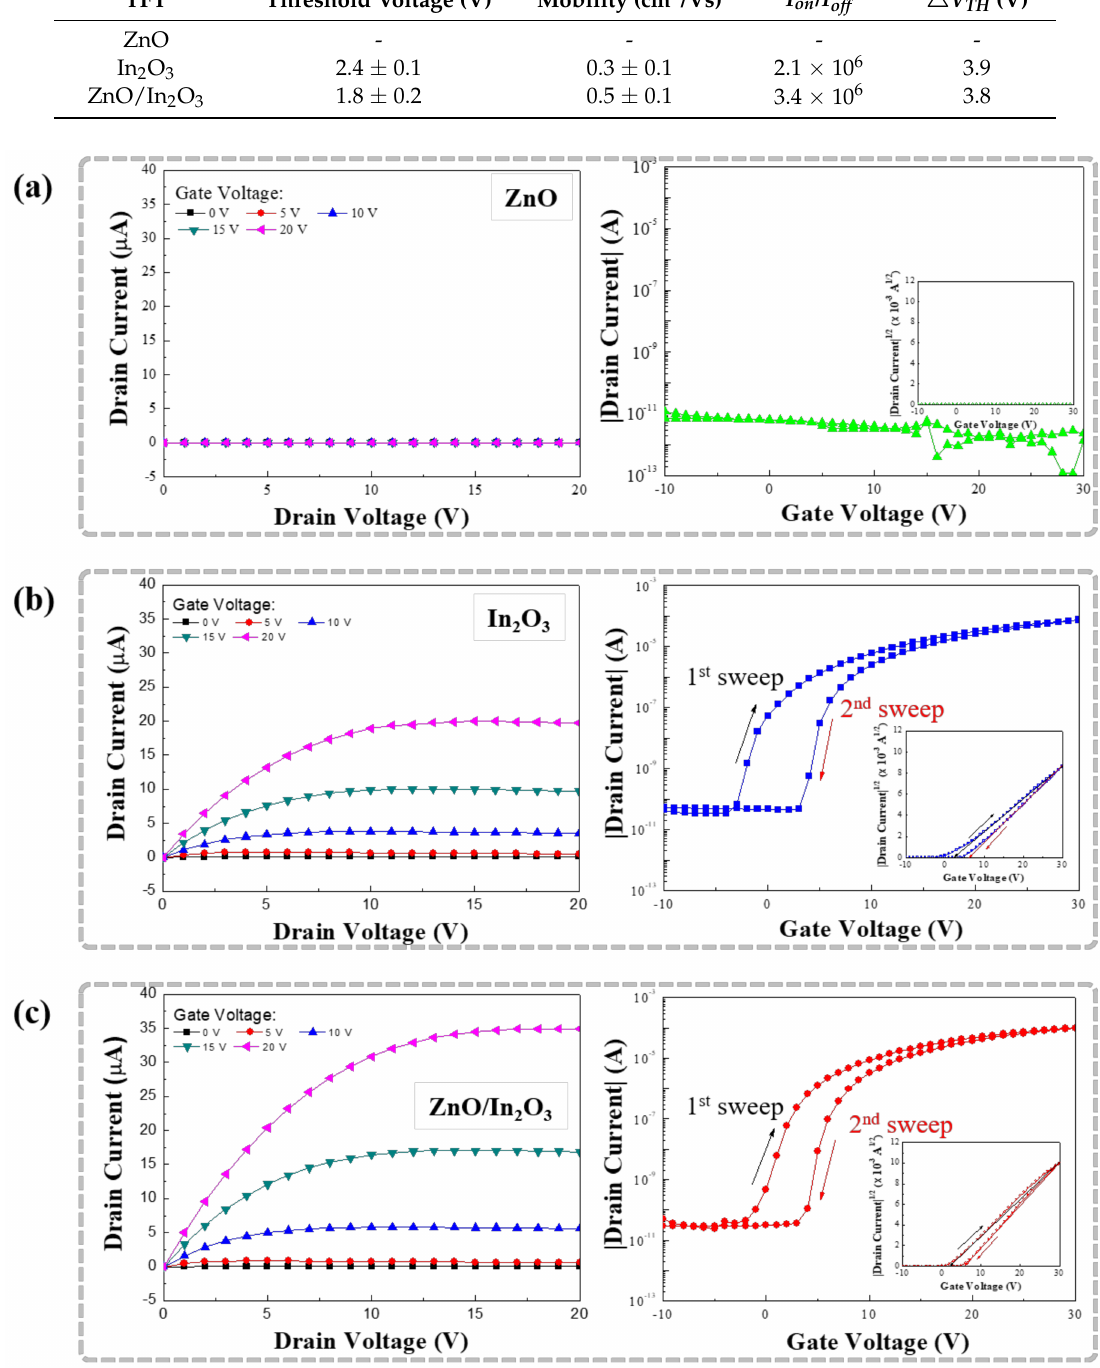
Figure 6. Electrical characteristics of TFTs fabricated with the ( a ) ZnO; ( b ) In 2 O 3 and ( c ) ZnO/In 2 O 3